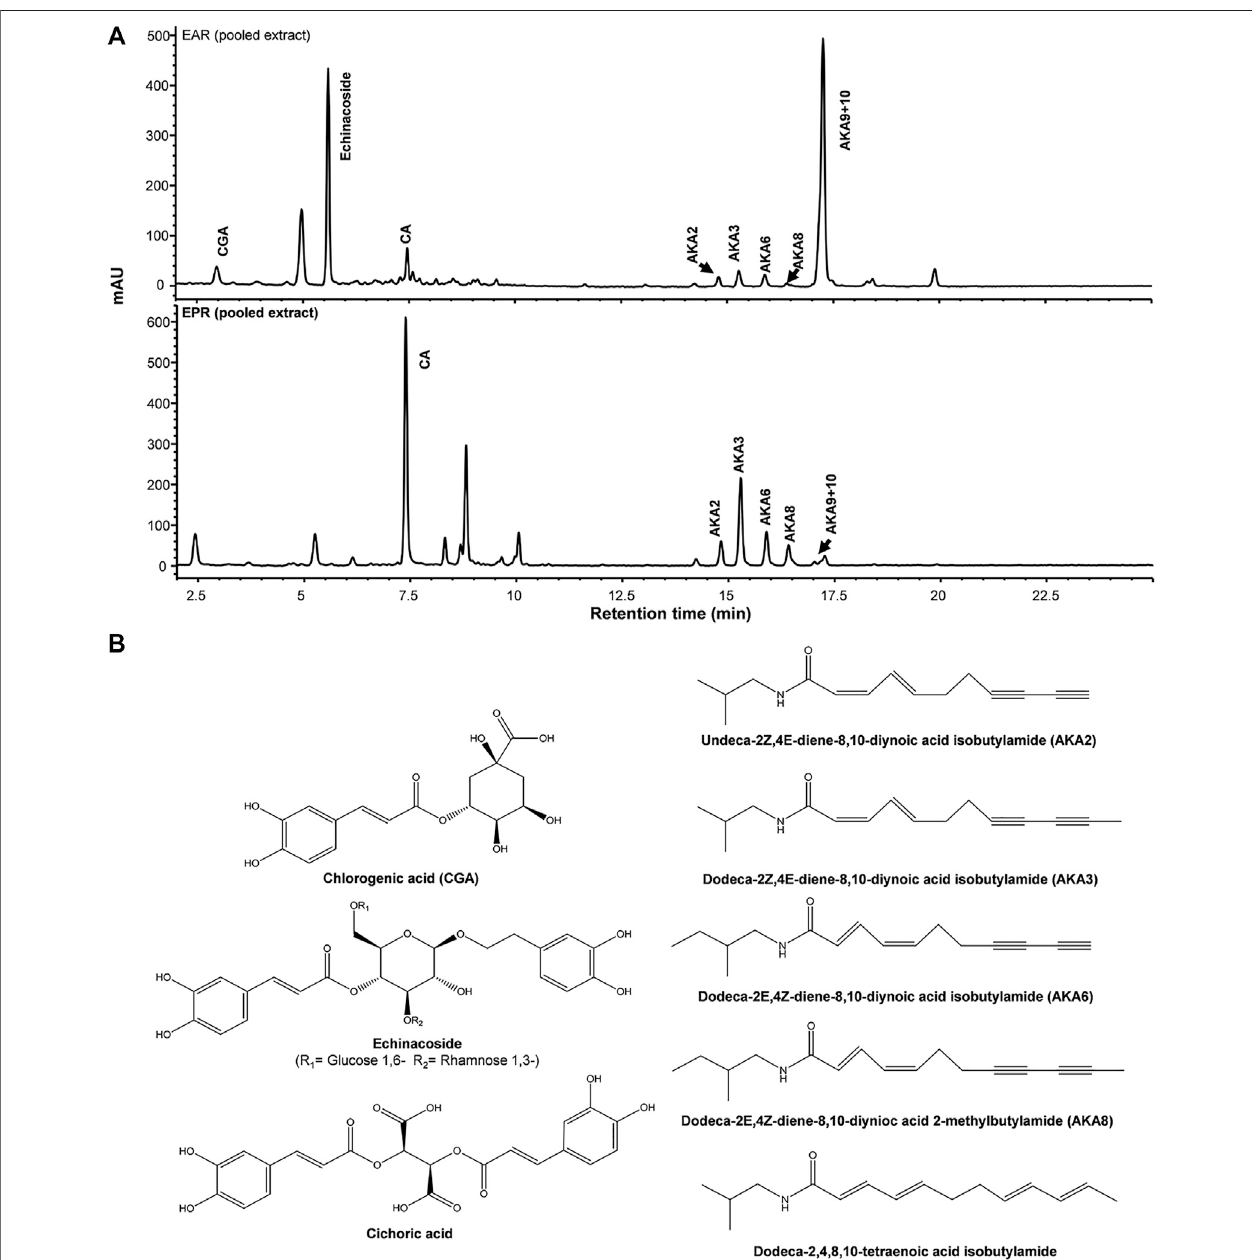
FIGURE 1 | Representative HPLC-DAD chromatograms of pooled E. purpurea (EPR) and E. angustifolia root extracts (EAR) at 280 nm (A) . Chemical structures of major caffeic acid detivatives and alkylamides (AKA) (B) .